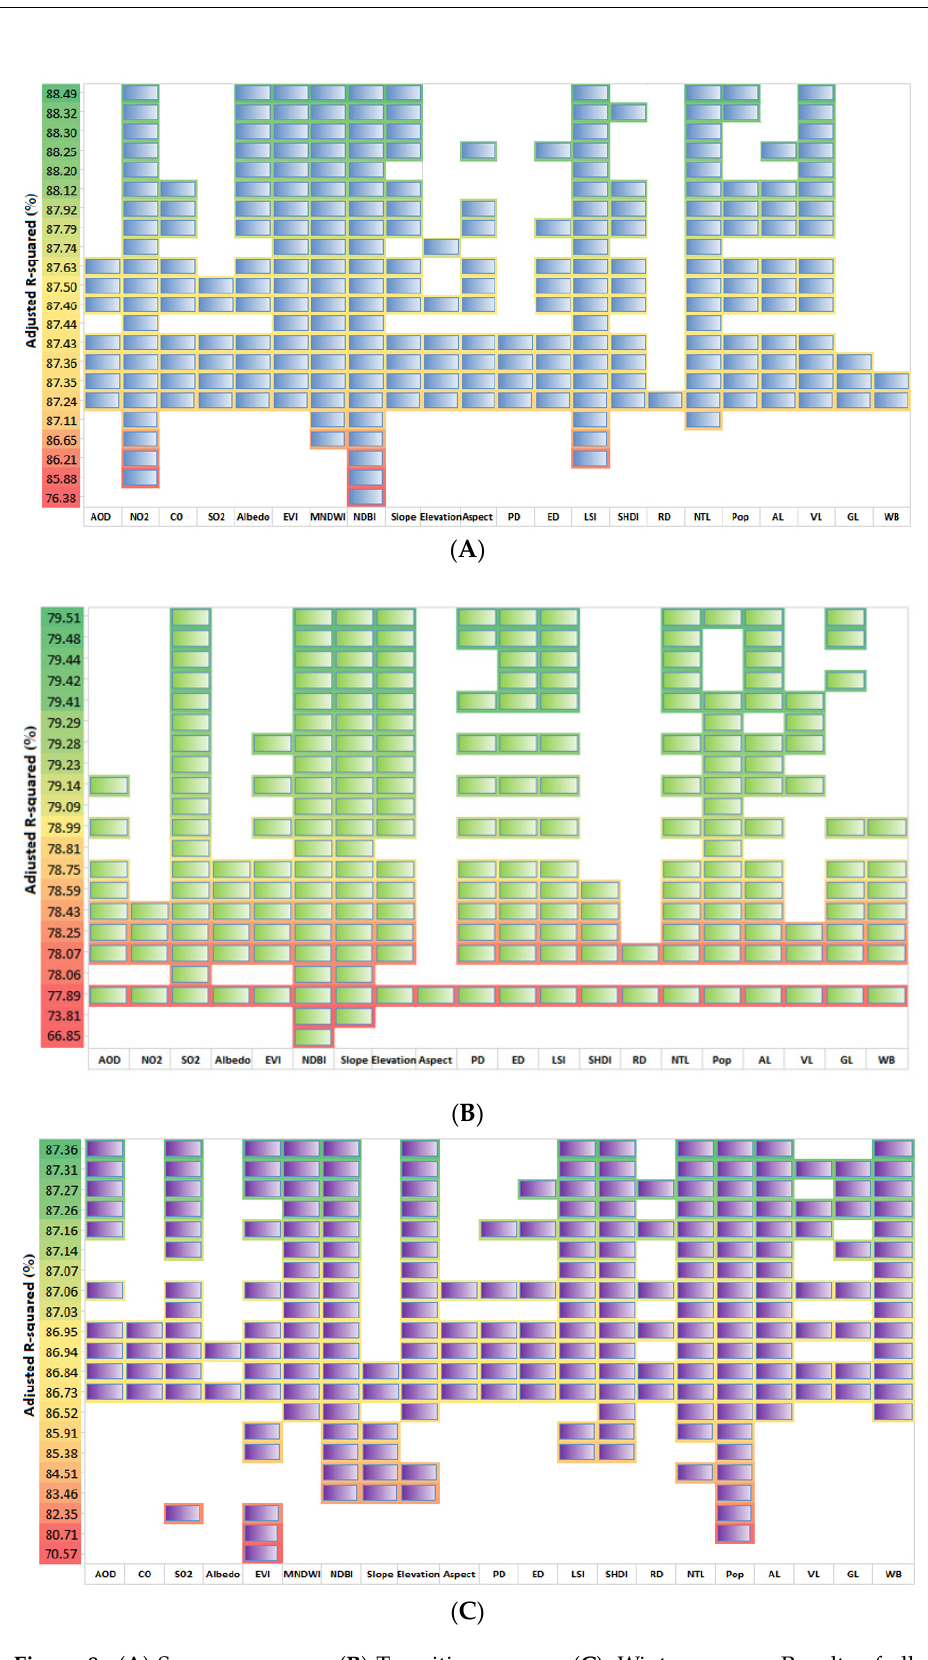
Figure 8. ( A ) Summer season. ( B ) Transition season. ( C ). Winter season. Results of all subsets regression of the integration of all influencing factors. The square indicates that a variable entered the regression model. Background color represents the value of adjusted